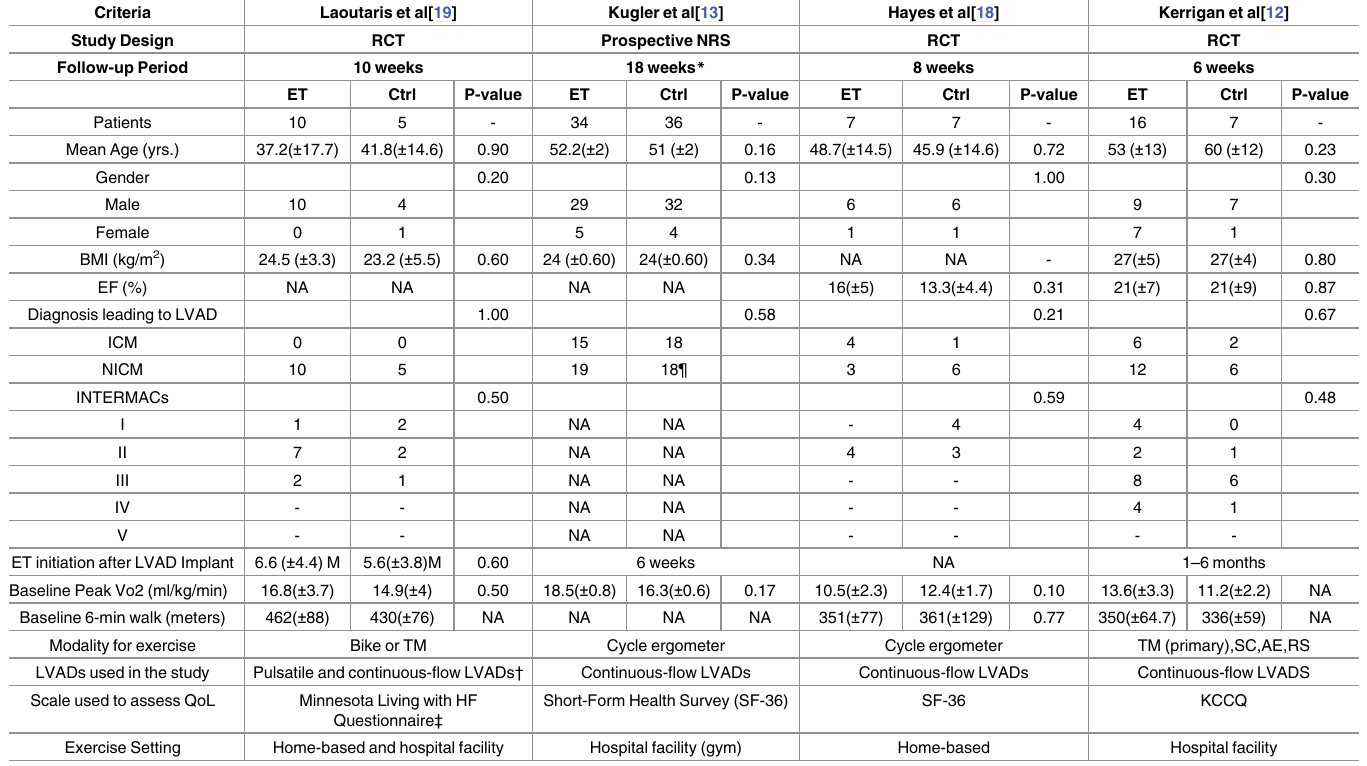
Table 4. Baseline characteristics of studies included in the quantitative sub-analysis. Criteria